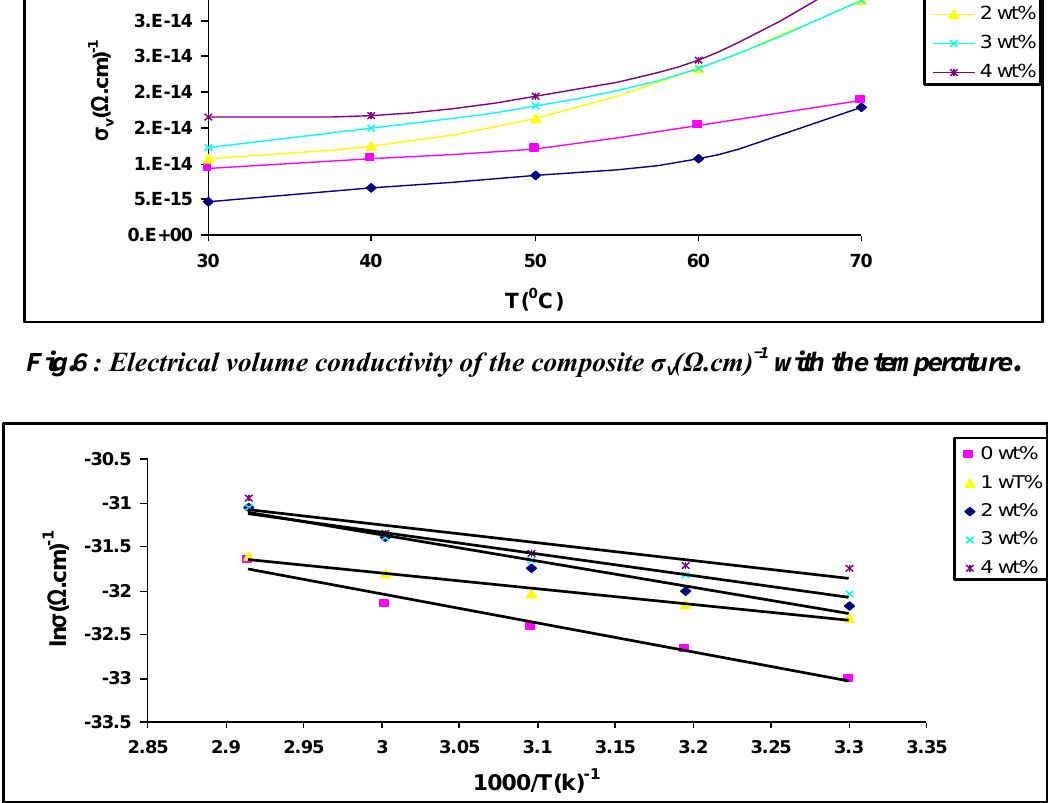
(Ω.cm) -1 with the temperature. v